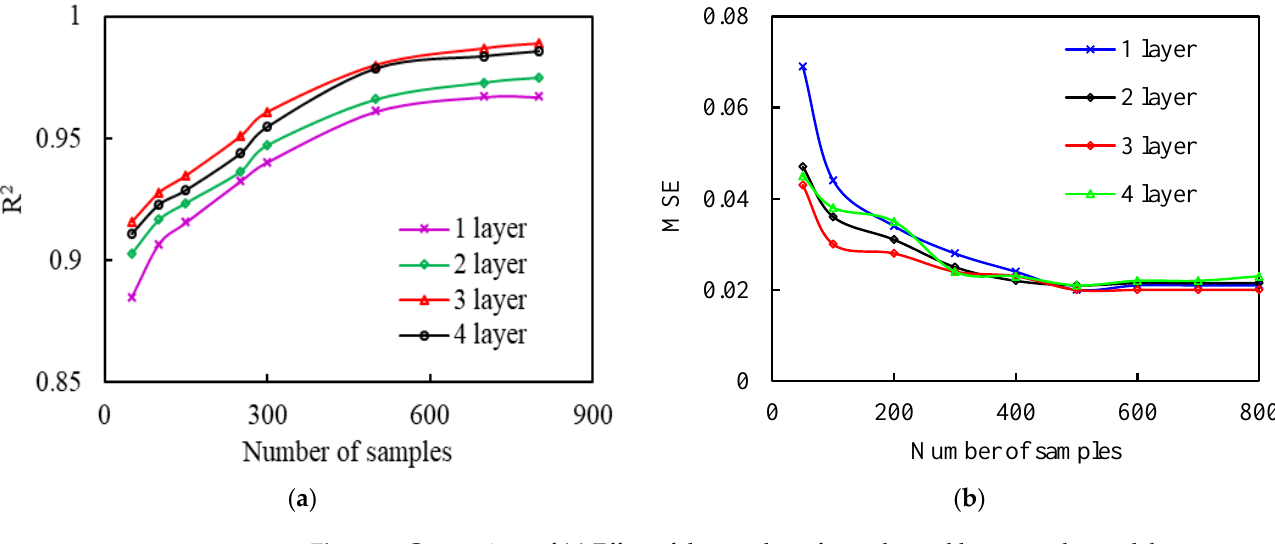
Figure 6. Comparison of ( a ) Effect of the number of samples and layers on the model accuracy and ( b ) Effect of the number of samples and layers on the model MSE.